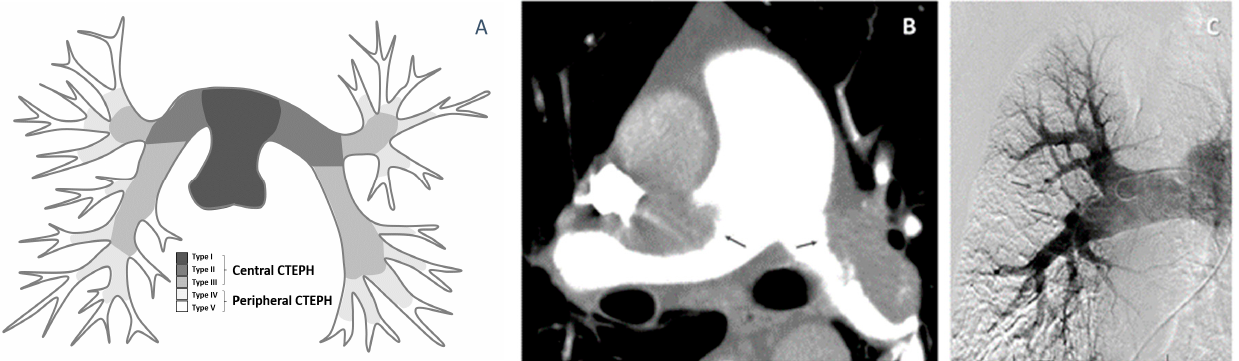
Figure 1. Central vs. peripheral type of CTEPH. ( A ). Scheme of central and peripheral CTEPH, ( B ) central CTEPH (by computer tomography), and ( C ) peripheral CTEPH (by angiography). CTEPH—chronic thromboembolic pulmonary hypertension.